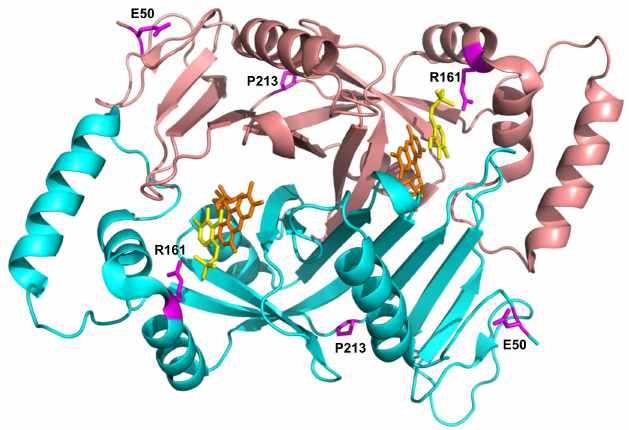
Figure 5. Location of the residues involved in novel pathogenic variants in PNPO structure. Crystal- lographic structure obtained in the presence of PLP (PDB: 1NRG; [17]). FMN and PLP in the active site are shown as sticks, in orange and yellow colour, respectively. The E50, R161, and P213 residues are shown as magenta sticks. D33 is not present in the electron density map, hence is not visible in the